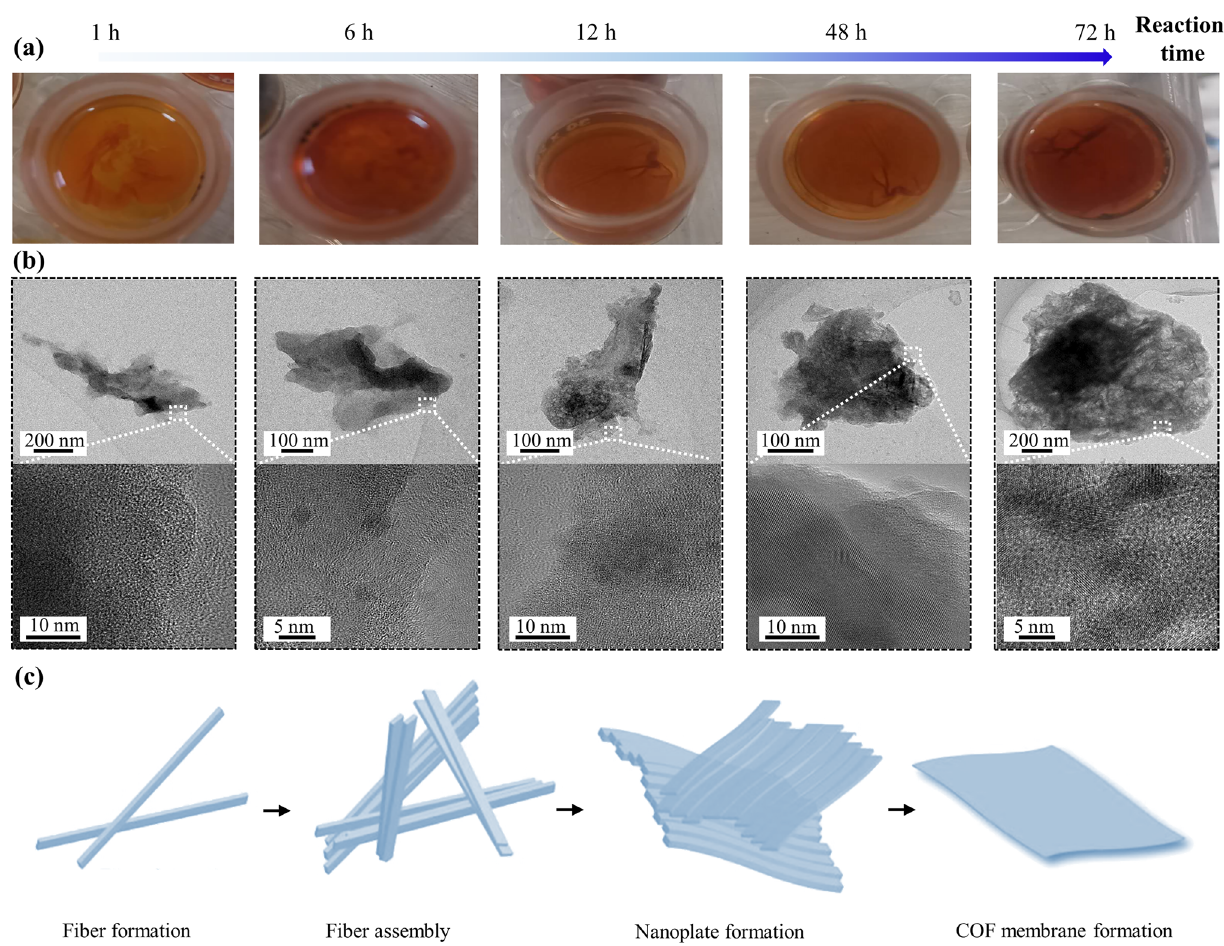
Fig. 2 Proposed mechanism for COF membrane formation (COF-DhTG Cl ). a Digital images, b TEM images and c scheme illustration of mate- rials obtained at different stages (fiber formation, assembled fibers, and nanoplate formation) of membrane